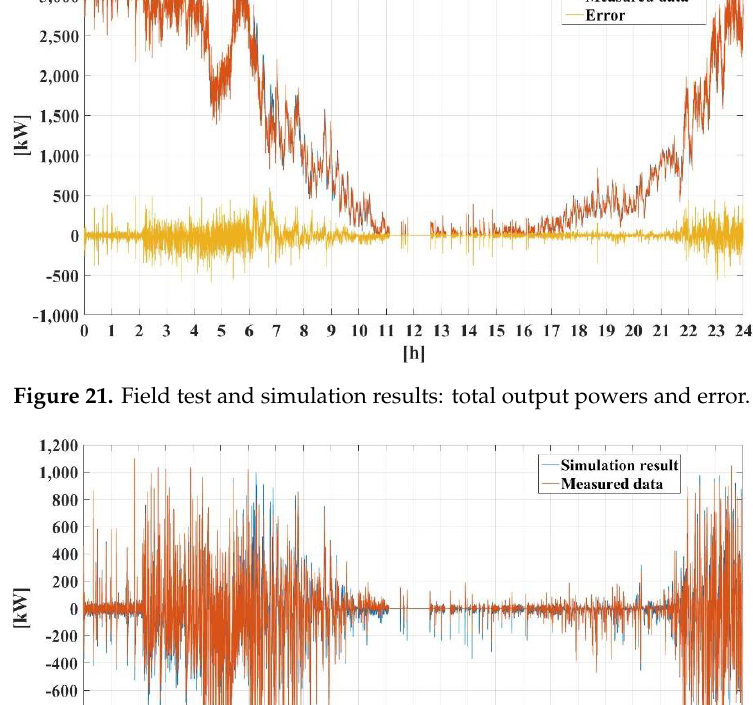
Figure 23. Field test and simulation results: output powers of ESS (zoomed segment 1). Figure 24. Field test and simulation results: output powers of ESS (zoomed segment 2). Based on the results of the simulation’s similarity to the measurement data, we verified the PCS capacity and time delay. The modified simulation model was carried out assuming that the PCS capacity was unlimited and that there was no time delay. Figure 25 shows the ESS output of the simulation result. As described above, we confirmed that the PCS output reached the minimum of −1741 kW. Figure 26 shows the fluctuation rate per minute of the modified computer analysis results. It can be seen that the target value of 10% or less was achieved in all results.